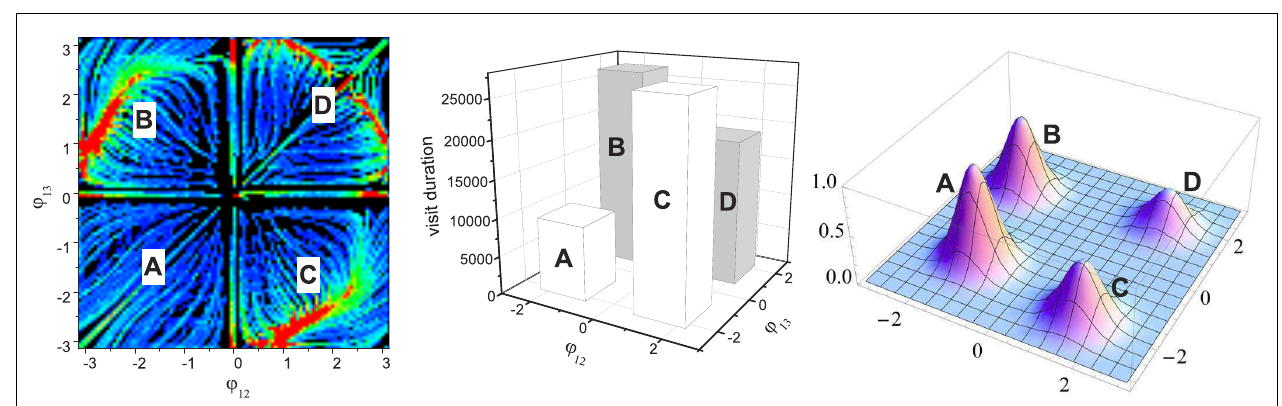
is not the result of chaotic search, but it is just a simplified quantification of the basic landscape shown in Figure 4 .These four bars effectively describe how long and how often the system orbit stays around each of the four search positions defined by the performance map (A,B,C,D) when chaotic exploration is enabled.The performance map was defined such that the pattern in the least stable region A has the highest score (peak value of 1.0).The other three peak performances were set to: B = 0.8, C = 0.6, D = 0.4.